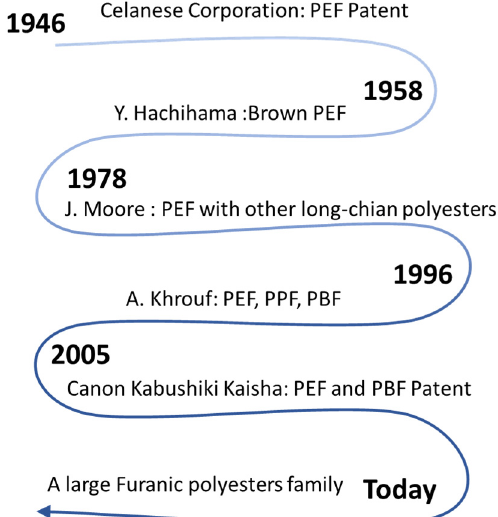
Figure 2. The history of PEF and synthesis of other furanic